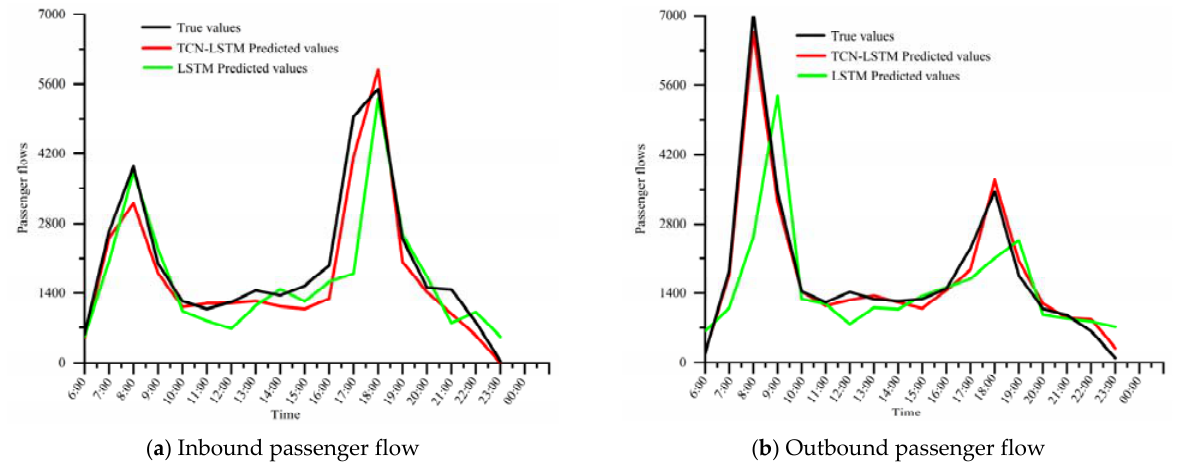
Figure 15. Prediction results of passenger flow at Jiazhoulu (medium passenger flow).